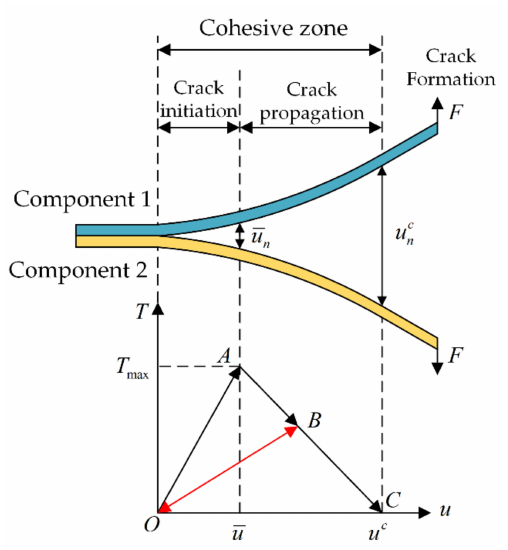
Figure 3. Cohesion zone and constitutive